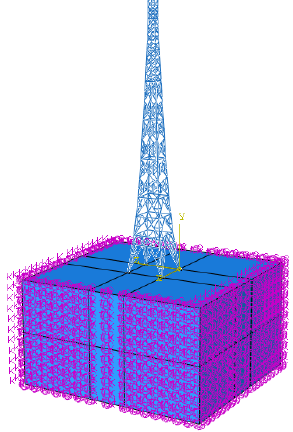
Fig. 3. Finite element of pile-soil-structure system Table 5. Values of 3D visco- elastic artificial boundary